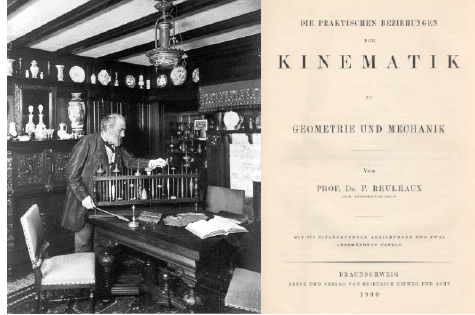
Figure 12. Franz Reuleaux (1829-1905) with his Spindle- Collection and his main work Kinematic (1875-1900) [1].